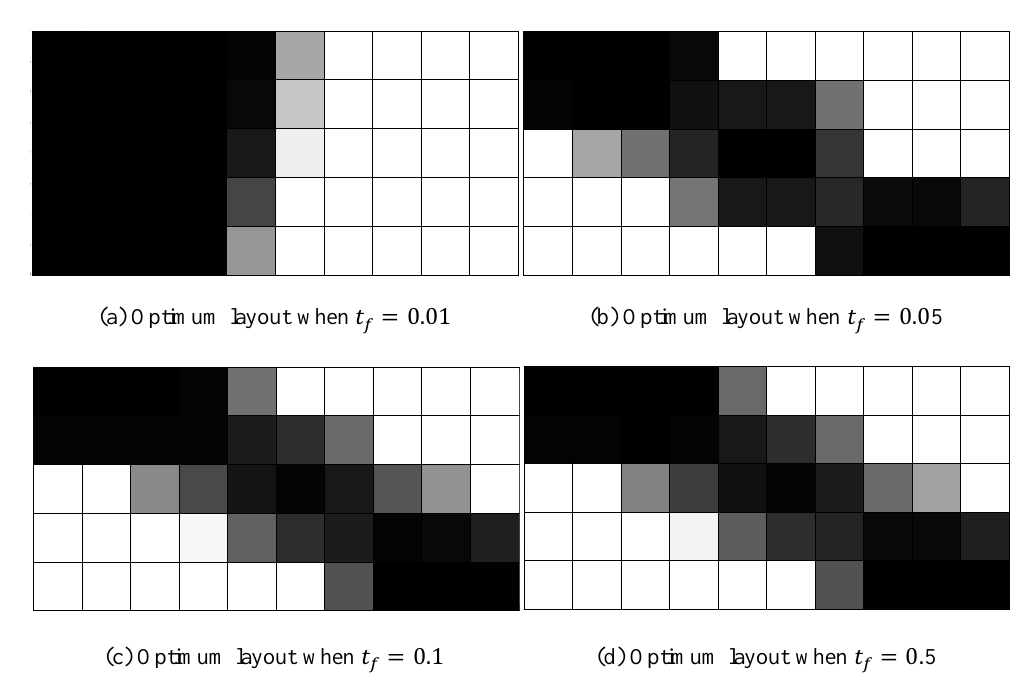
Figure 9. Optimized results for Michell-type structure with dynamic analysis.